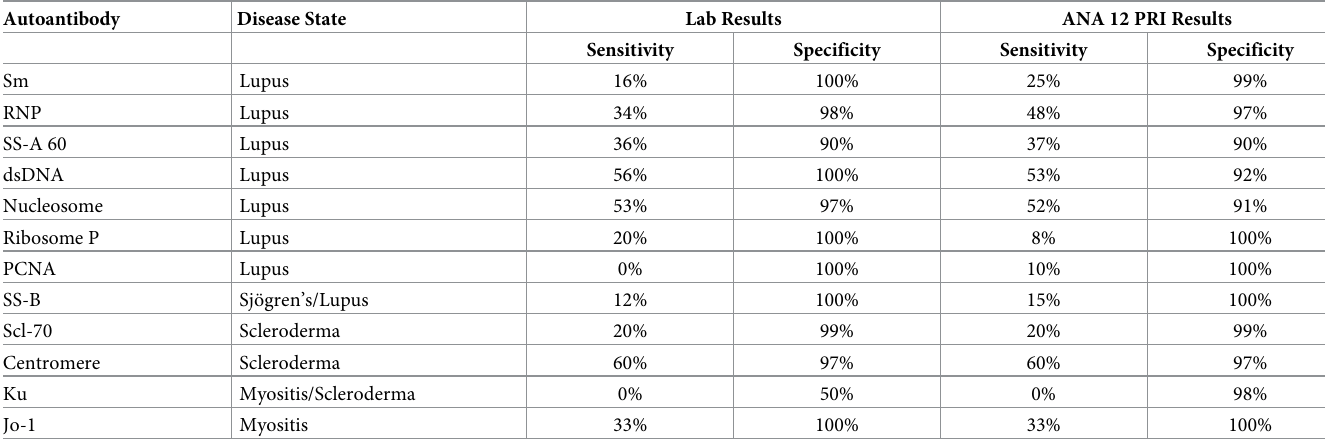
Table 5. Clinical sensitivity and